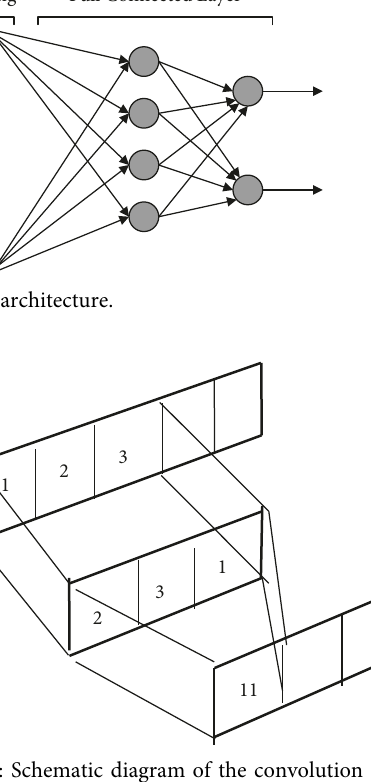
Figure 8: Input vector.